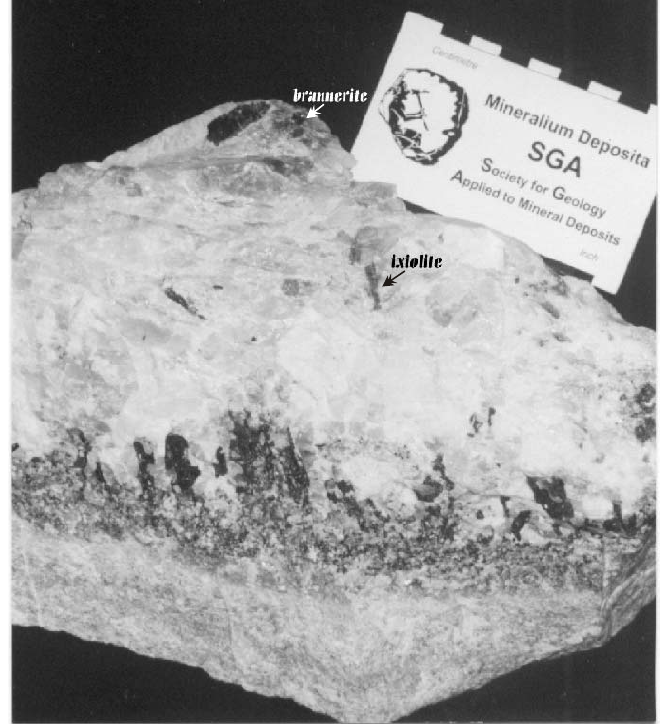
Fig. 2 – Sample from the border zone of the Quintos pegmatite with the en- closing quartzites at the bottom, followed by a first contact zone with quartz, albite and comb-textured black dravite growing perpendicularly from the wall to the interior of the pegmatite. Ixiolite and brannerite (arrows) occur in the beginning of the zone II (‘‘wall zone’’), which is formed by albite quartz and subordinated K-feldspar, muscovite, and dravite. Apatite, zircon and garnet are small grain-size accessory minerals in both